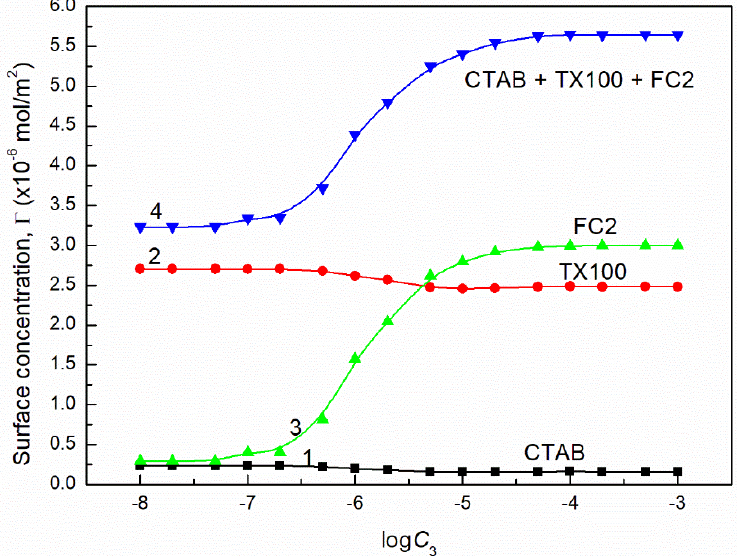
Figure 18. A plot of the concentration of CTAB (curve 1), TX100 (curve 2), FC2 (curve 3) and their sum (curve 4) in the mixed monolayer at the water − air interface formed by the CTAB + TX100 + FC1 mixture at the constant concentration of the binary CTAB + TX100 mixture ( C 12 ) and γ LV = 50 mN/m as well as calculated from Equation (12) based on the contribution of the given surfactant to the reduction of water surface tension vs. the logarithm of the FC2 concentration ( logC 3